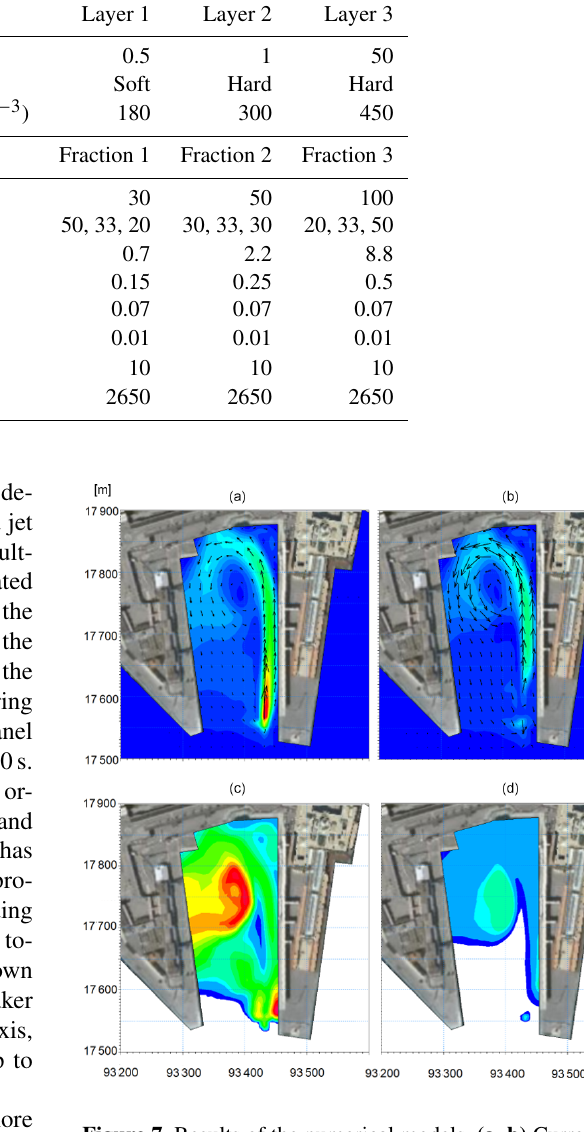
Figure 7. Results of the numerical models. (a, b) Current intensity and direction in the bottom layer and (b, d) in the layer correspond- ing to the axis propeller. (c, d) Resulting suspended sediment con- centration (SSC, mgL − 1 ) in the same layers as in panels (a) and (b) . The images refer to the undocking of the cruise vessel repre- sentative of dock 1012. Land background from © Google